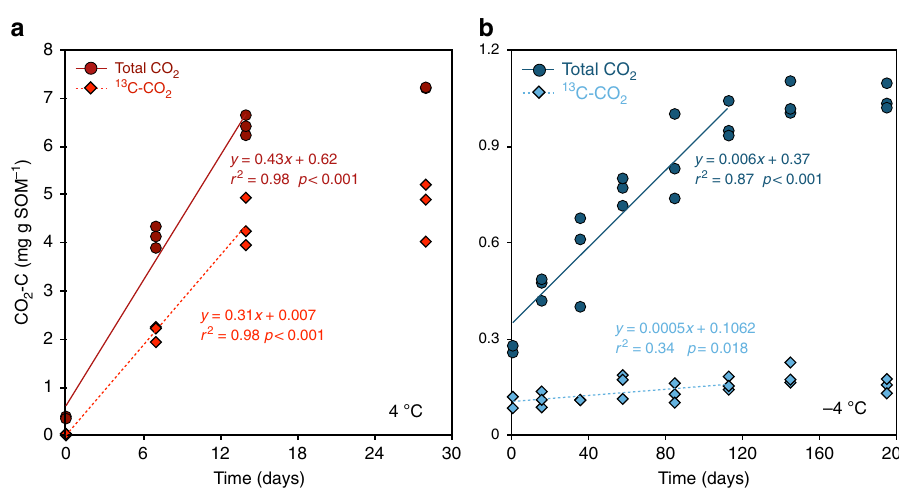
Fig. 1 CO 2 and 13 C-CO 2 from the added 13 C-cellulose were produced in both unfrozen and frozen soil samples. Changes in CO 2 and 13 C-CO 2 concentrations with time (showing fi tted linear functions) in the samples incubated at 4 °C (over 14 days; panel a , red circles and diamonds) and − 4 °C (over 113 days; panel b , blue circles and